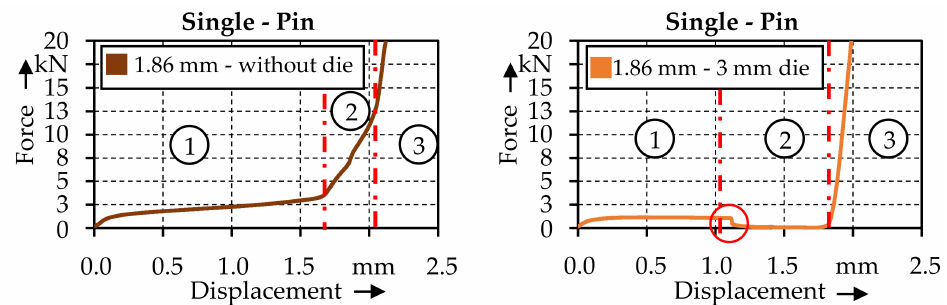
Figure 9. Comparison of the force displacement curves of the two investigated joining strategies based on the 1.86 mm pin